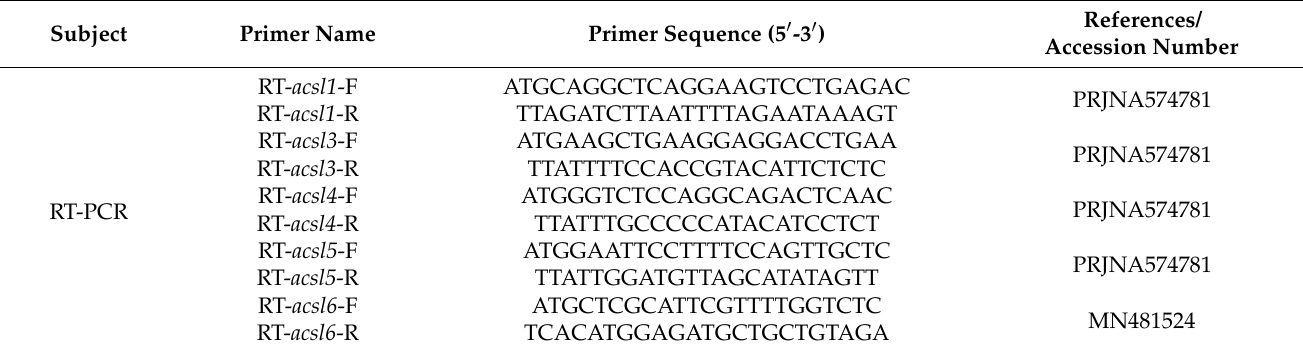
Table 1. PCR primers sequence used in this